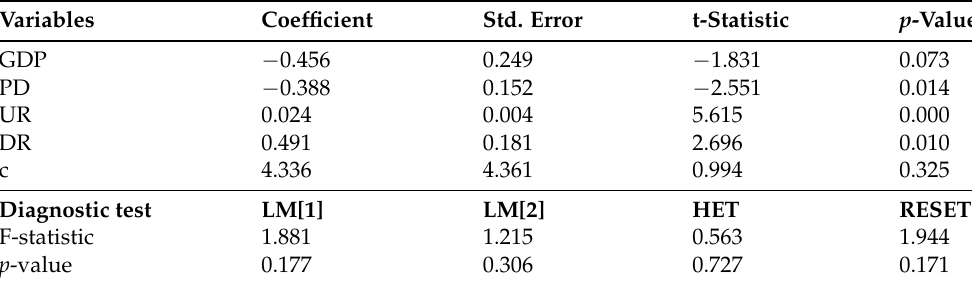
Table 4. Long-run coefficients. LM ( n ) = Lagrange multiplier test for the n th order autocorrela- tion; RESET = Ramsey’test for functional misspecification; HET = Breusch-Pagan-Godfrey’ test for